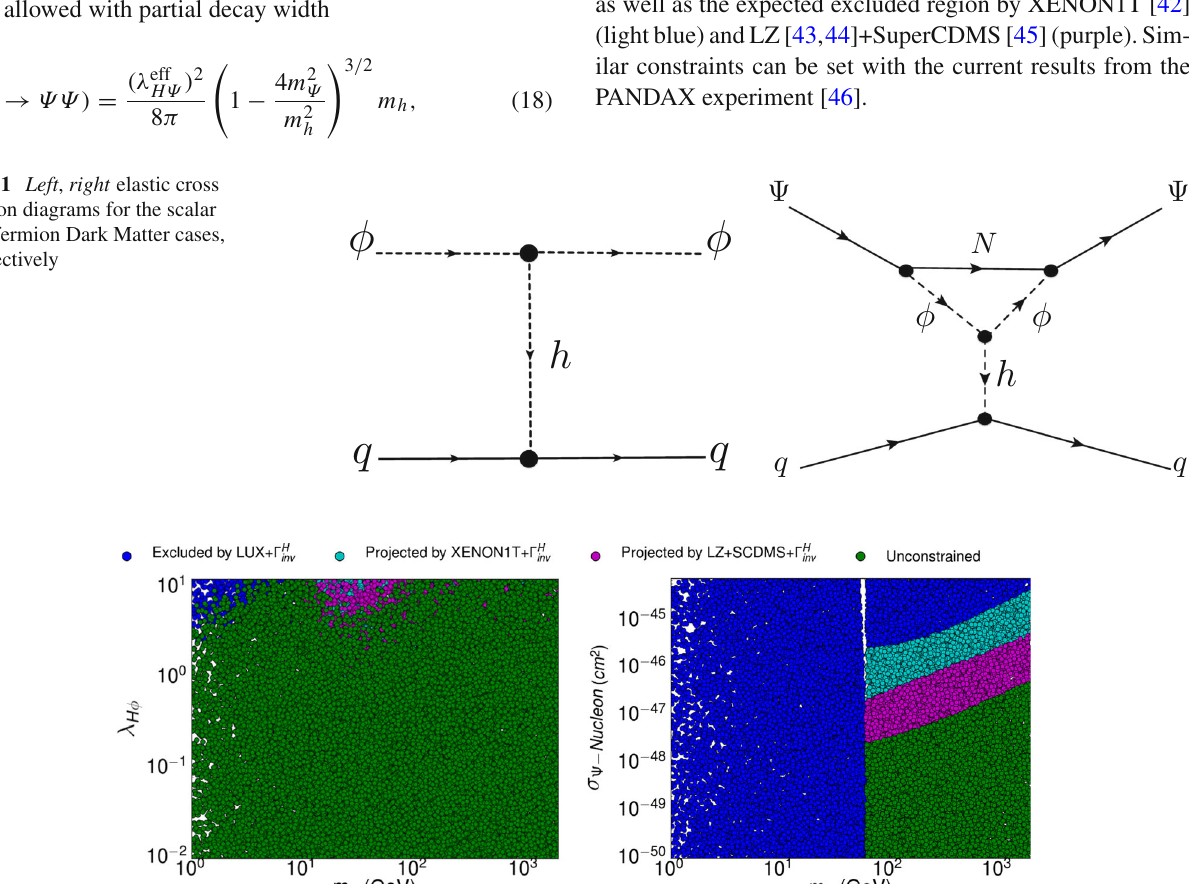
Fig. 2 Constraints on the Higgs portal coupling for fermion